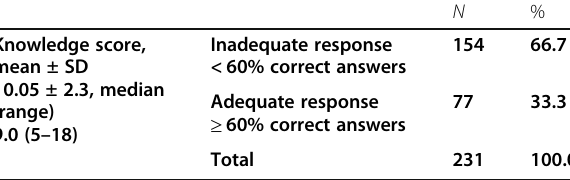
Table 4 OSA knowledge score among all physicians